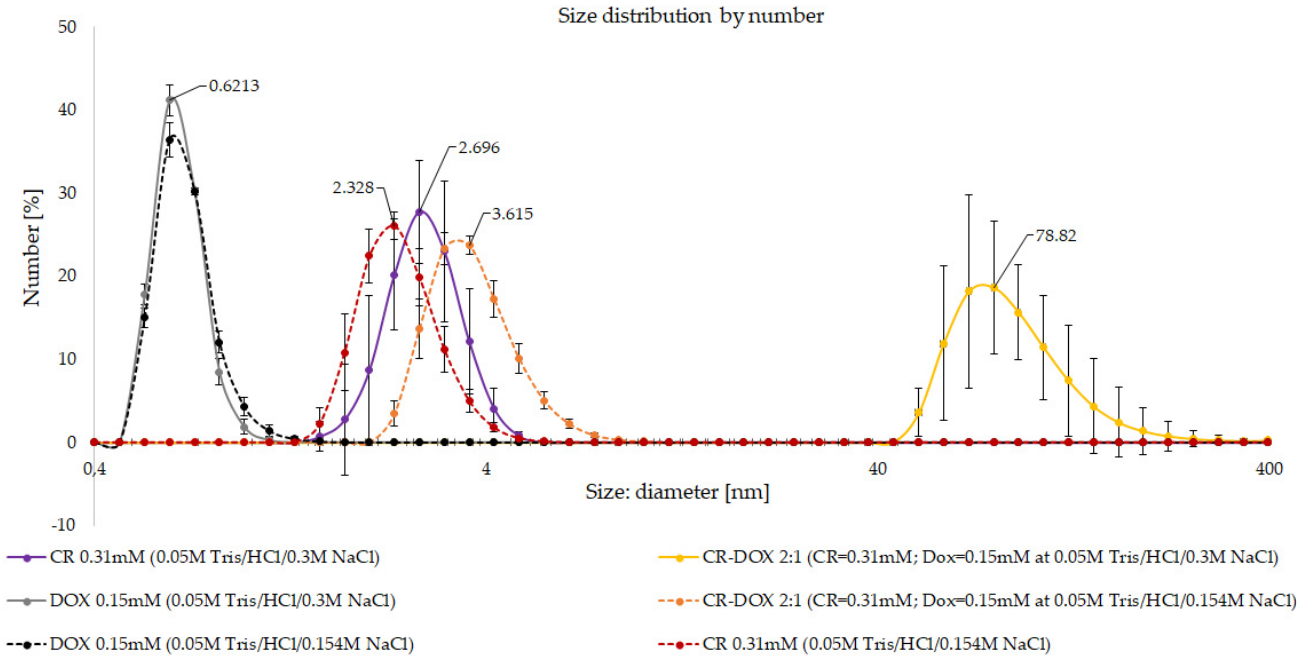
Figure 3. DLS analysis of CR-Dox complexes. The effect of ionic strength on the hydrodynamic diameter of CR, Dox, and CR-Dox complex. Lower concentration probes (final concentration of CR: 0.31 mM, Dox: 0.15 mM) at two different 0.05 M Tris/HCl buffers supplemented with: 0.154 M or 0.3 M NaCl.